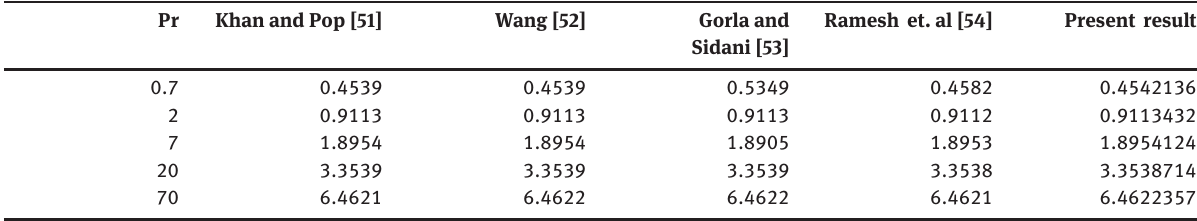
Table 3: Comparison for HAM results of the local Nusselt number − θ (cid:3) (0) in the case of β = λ = 0 R d = N t = N b = 0, M = 0.1, (cid:2) θ = −0.55, Ec = 0.1, A = 0, Le = 10